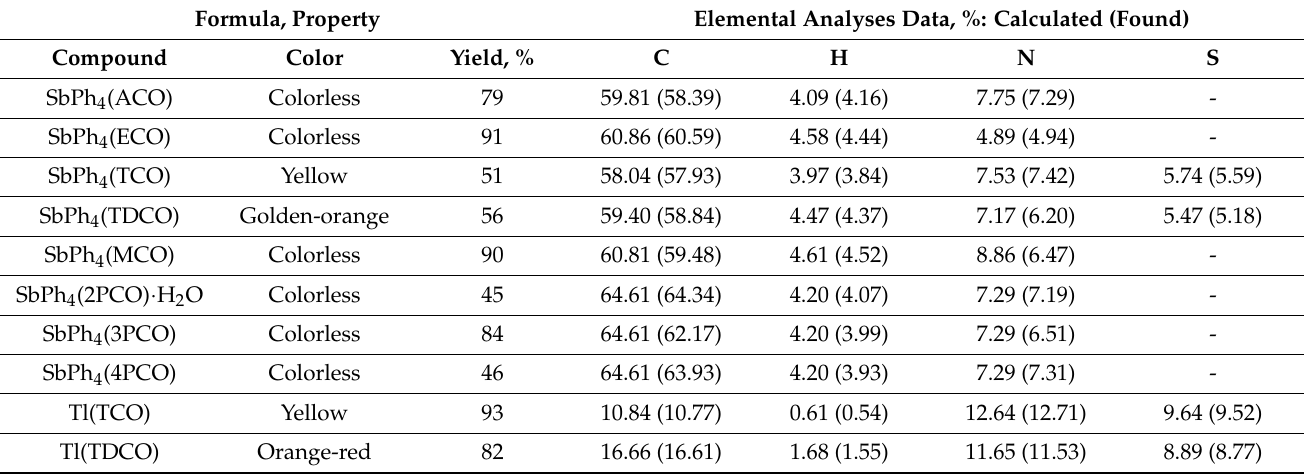
Table 3. Yield, color, and composition of the obtained tetraphenyl-antimony(V) cyanoximates and two of their precursors: Tl(I)